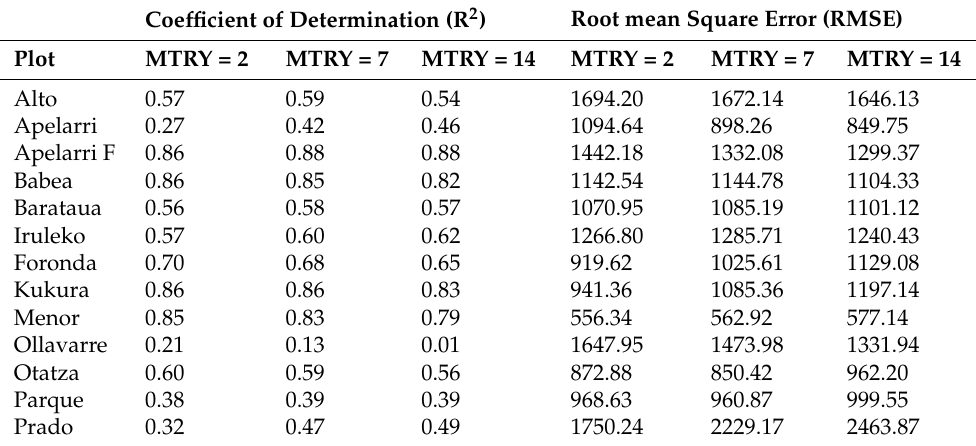
Table 2. Coefficient of determination (R 2 ) and root mean square error (RMSE) of the predicted yield of each entire plot (validation) using the information from the rest of the plots. MTRY is indicative of the number of variables used to create each